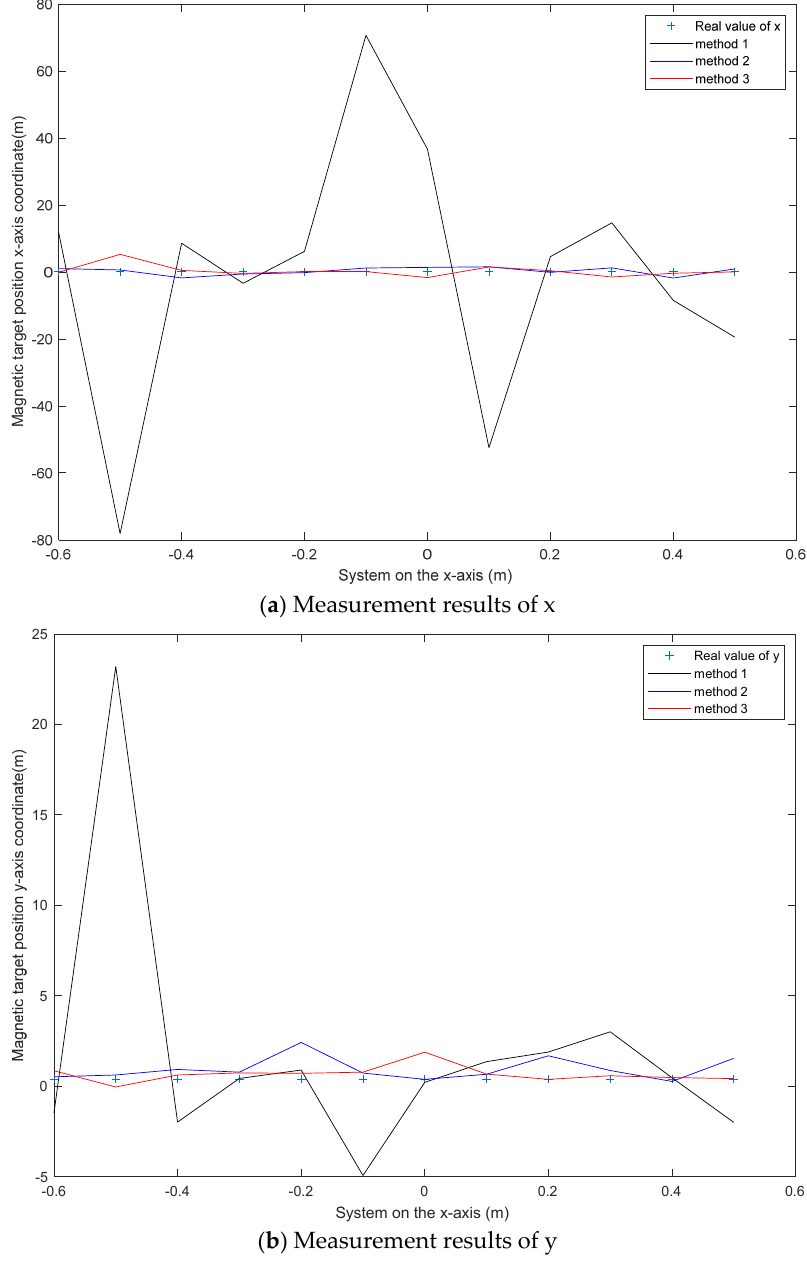
( b ) Measurement results of y